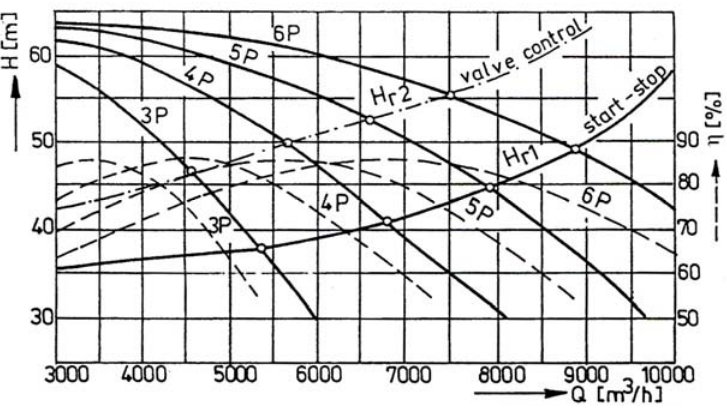
Figure 3. Characteristic curves H ‐ Q , η‐ Q and the operating points for different parallel ‐ connected pumps.